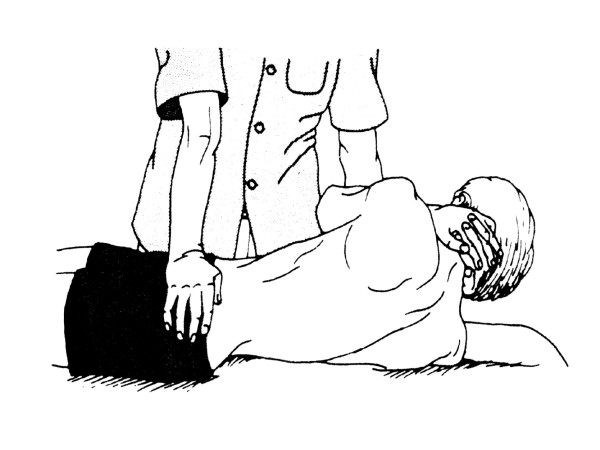
Spinal manipulation technique utilized in this study(5;47;54–56). (Reprinted with permission of the American Physical Therapy Association from Cibulka MT. The treatment of the sacroiliac joint component to low back pain: a case report. Phys Ther. 1992;72:917–922.)